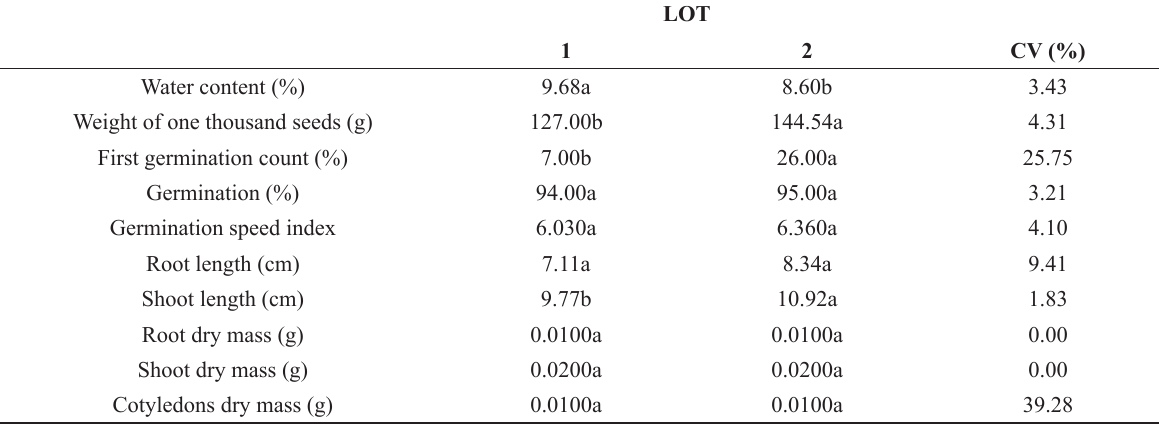
Water content, weight of one thousand, first germination count, germination, germination speed index, root length (RL), shoot length (SL), root dry mass (RDM), shoot dry mass (SDM) and cotyledons dry mass (CDM) of Libidibia ferrea